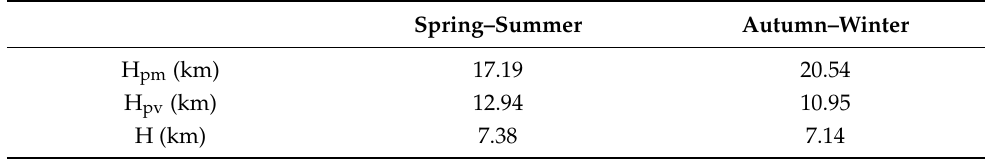
Table 3. Scale heights (H pm , H pv , and H )